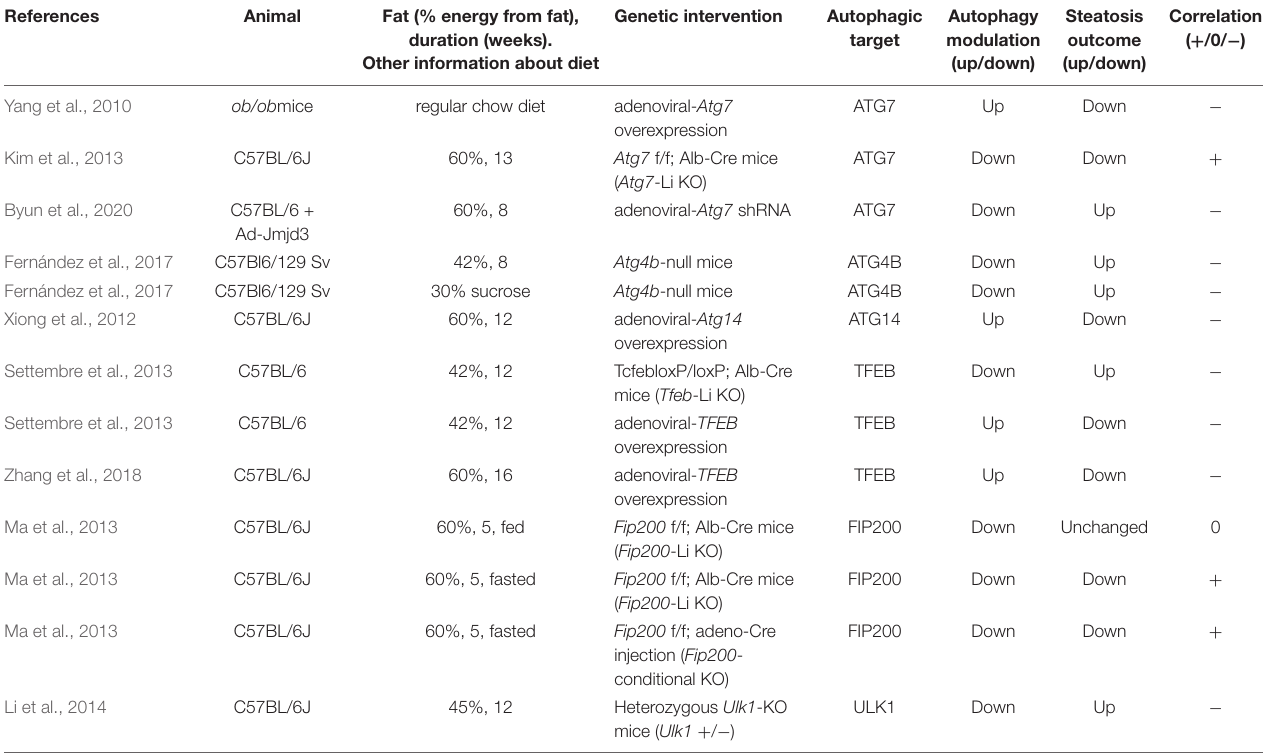
TABLE 5 | Autophagy protein genetic interventions and obesity models.